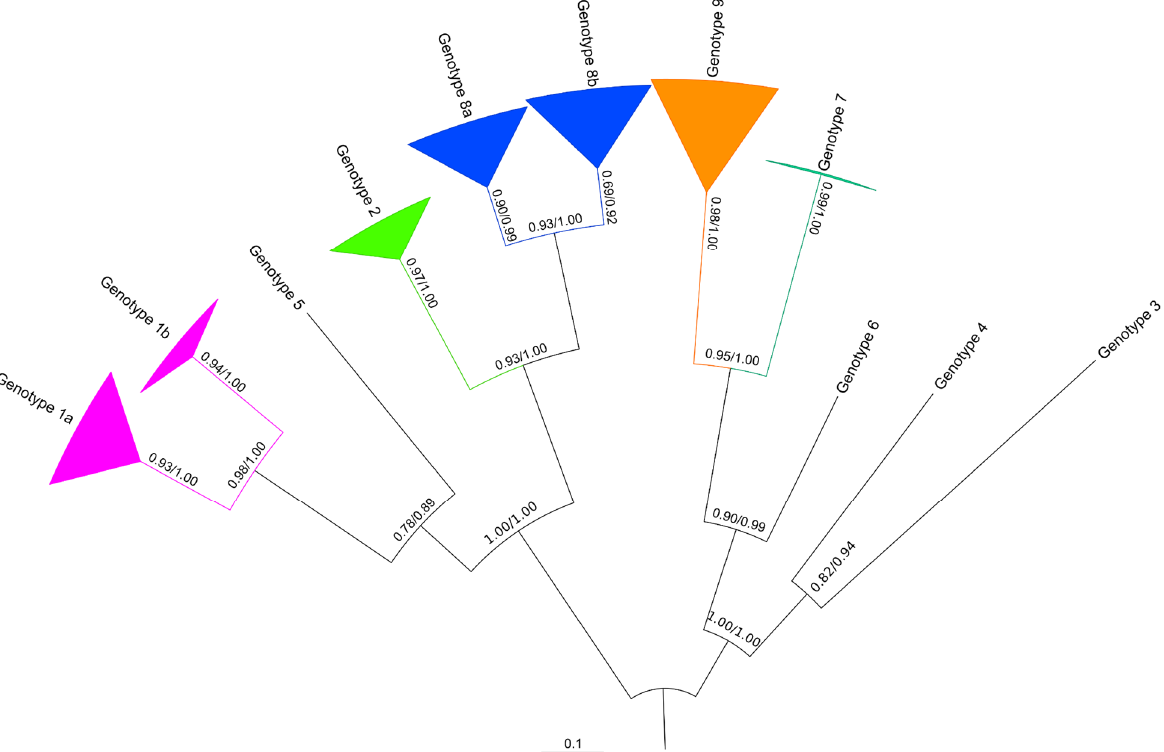
Figure 3. Phylogenetic tree of VP1 nt sequences generated for LV strains from the wild rodents listed in Table 1. Support values are found above or next to each node: approximate likelihood ratio test of the maximum likelihood (aLRT)/posterior probabilities of the Bayesian reconstruction (BPP). Genotype sequences with over 85% identity were collapsed.